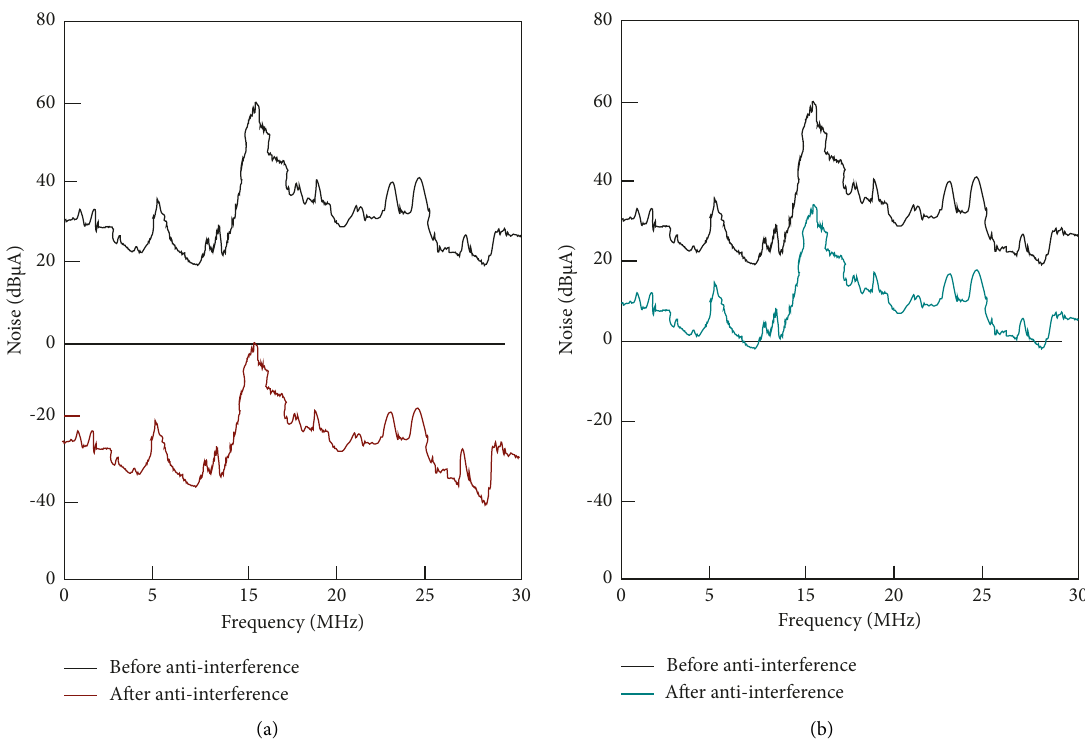
Figure 6: Immunity test results. (a) The monitoring system of this study. (b) A traditional monitoring system.